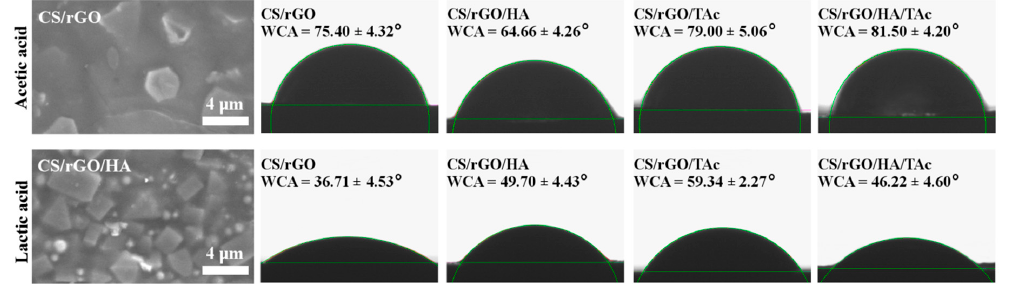
Figure 6. Representative SEM (Scanning Electron Microscopy) images of CS nanocomposites surface images of water droplets on the samples’ surface with mean values of water contact angle—WCA (CS—chitosan, rGO—reduced graphene oxide, HA—hydroxyapatite, TAc—tannic acid, AAc—acetic acid, LAc—lactic acid).